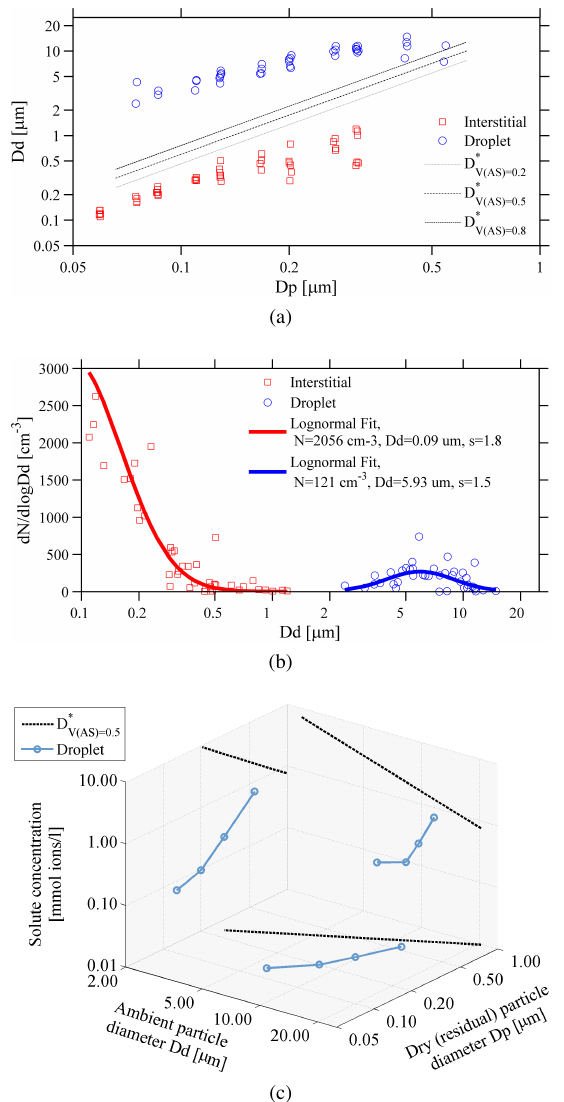
Fig. 5. (a) Ambient particle diameter, D d , as a function of dry Fig. 5: (a) Ambient particle diameter, D d , as a function of (residual) diameter, D P , during the event. The three black lines dry (residual) diameter, D p , during the event. The three black show the critical diameter of activation D ∗ for different vol- lines show the critical diameter of activation D ∗ for dif- V(AS) V ( AS ) ume fractions of ammonium sulfate in the particles. (b) Ambient ferent volume fractions of ammonium sulfate in the particles. particle size distribution, d N/ dlog D d , for interstitial particles and (b) Ambient particle size distribution, dN/dlogD d , for inter- droplets during the event. The bold lines are log-normal fits to the stitial particles and droplets during the event. The bold lines data. (c) Estimated cloud droplet solute concentration as a function are log-normal fits to the data. (c) Estimated cloud droplet of the droplet size and dry (residue) particle size on 30 August 2010, solute concentration as a function of the droplet size and dry at 23:51UTC. The projections show droplet solute concentration as (residue) particle size on 30 August 2010, at 23:51 UTC. The a function of interstitial particle diameter (left) and ambient particle projections show droplet solute concentration as a function of diameter (right). The bottom projection shows the ambient particle interstitial particle diameter (left) and ambient particle diam- diameter, D d , as a function of dry (residual) particle diameter, D P . eter (right). The bottom projection shows the ambient par- The dashed lines show the limits of droplet activation for an ammo- ticle diameter, D d , as a function of dry (residual) particle nium sulfate volume fraction of 0.5 according to the Köhler theory diameter D p . The dashed lines show the limits of droplet in each activation for an ammonium sulfate volume fraction of 0.5, according to the K¨ohler theory in each projection.